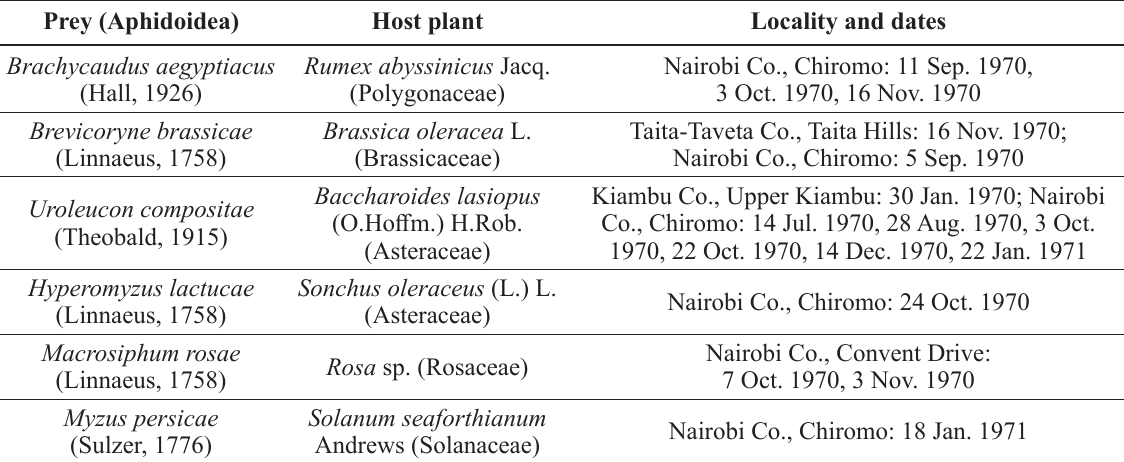
Table 1. Reported prey, host plants and localities for Afrosyrphus schmuttereri sp. nov. in Kenya (adapted from Schmutterer 1974). Hemipteran names follow Favret (2019) and plant names follow The Plant List